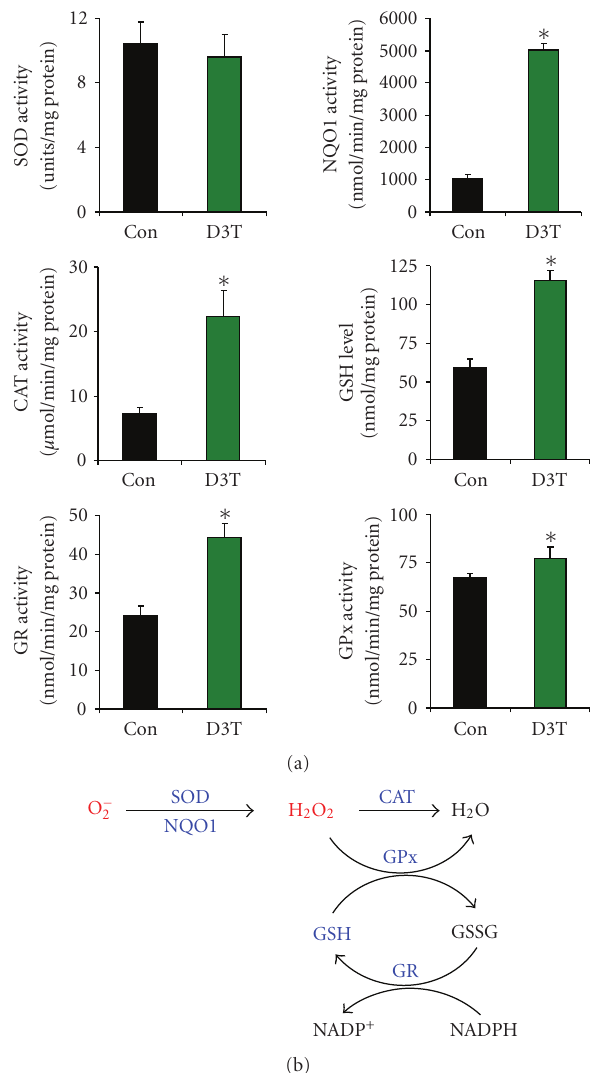
Figure 5: Induction of endogenous antioxidants by D3T in cultured H9c2 cardiomyocytes and schematic illustration of ROS detoxification by antioxidants. (a) H9c2 cells were incubated with 100 μ M D3T in culture medium for 48 hours followed by measurement of the indicated antioxidants, as described under Materials and Methods section. Data represent mean ± SEM ( n = 3-4) . ∗ : significantly di ff erent from control; (b) detoxification of superoxide and H 2 O 2 by various cellular